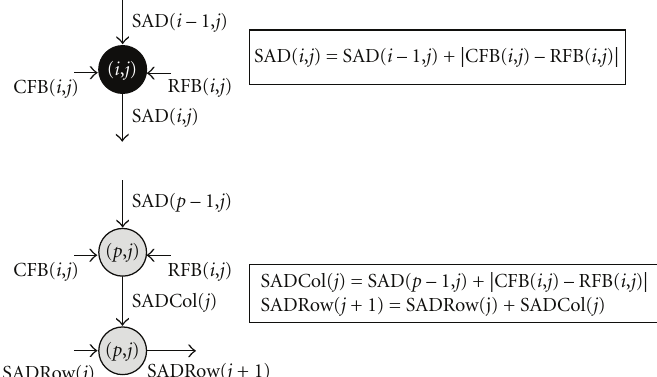
Figure 3: Operation to be performed inside each node shown in the dependence graph in Figure 2. SADCol( j ) is the output of the final “dark” nodes in the j th